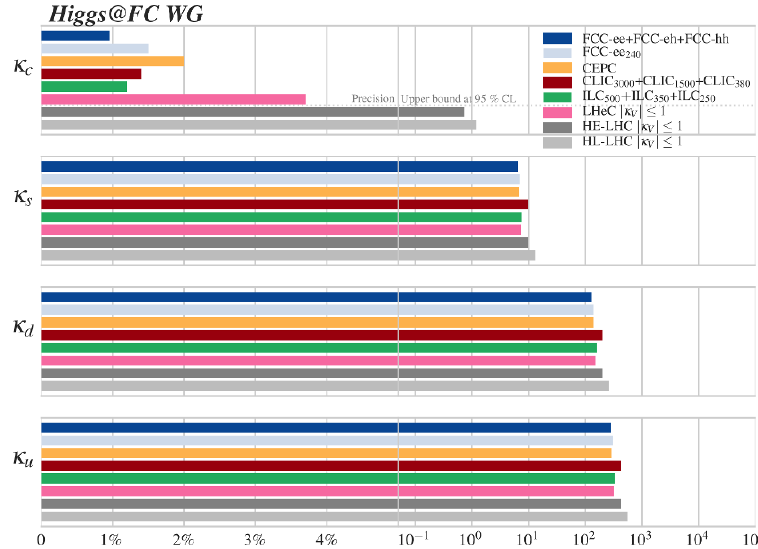
Figure 12 . Summary plot illustrating the limits that can be obtained from rare Higgs decays on the couplings.